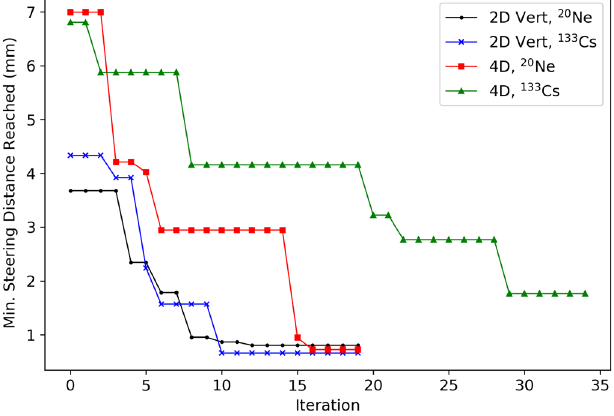
FIG. 3. Best steering distance reached as a function of number of GP iterations, for 2D and 4D